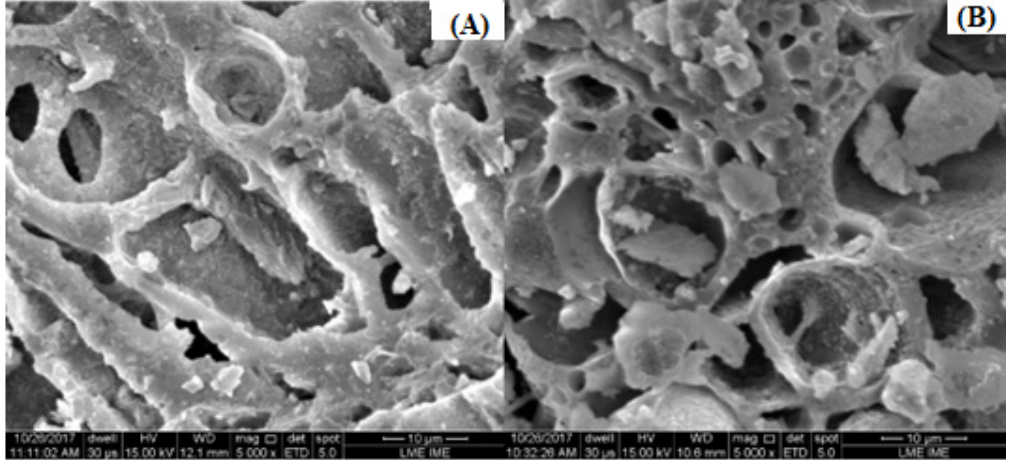
Figure 5. ( A ) Micrographs of biochar in nature obtained at 400 °C. ( B ) Micrographs of biochar in nature obtained at 450 °C.